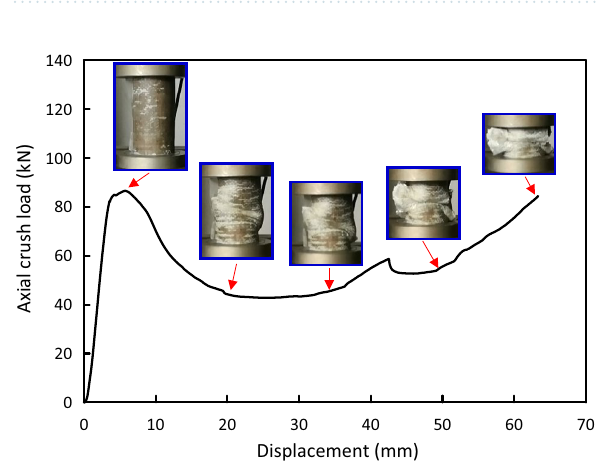
Figure 6. Load–displacement and crushing history for Al-8J test specimen.